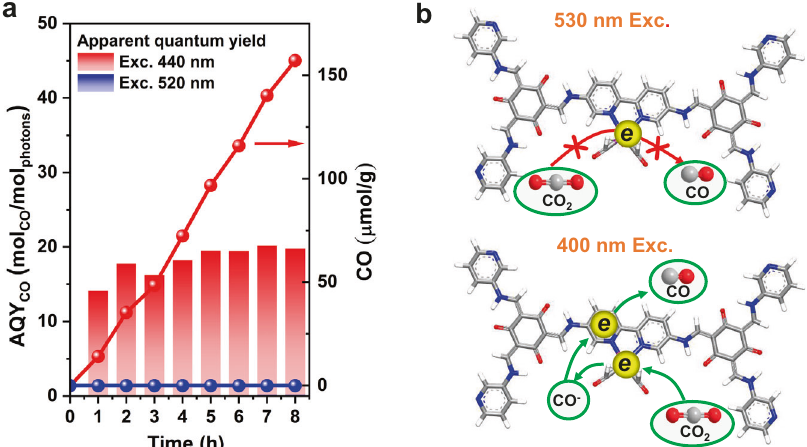
Fig. 9 Photocatalytic performance. Photocatalytic evolutions of CO by Re-TpBpy under 520 and 440 nm excitation ( a ) and schematic diagram to rationalize the catalytic performance under two excitation conditions ( b ). Source data are provided as a Source data